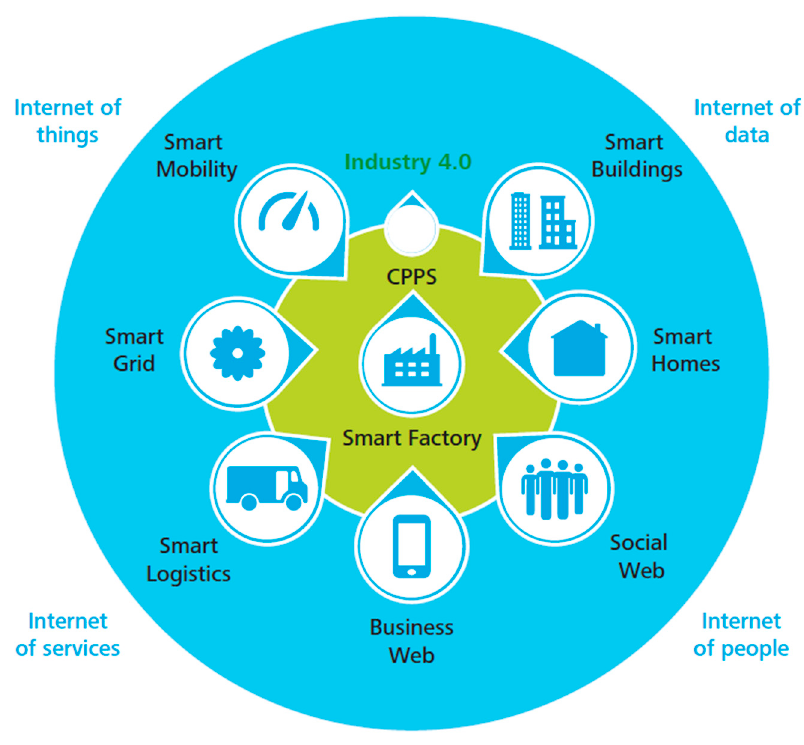
Figure 2. The Industry 4.0 Environment